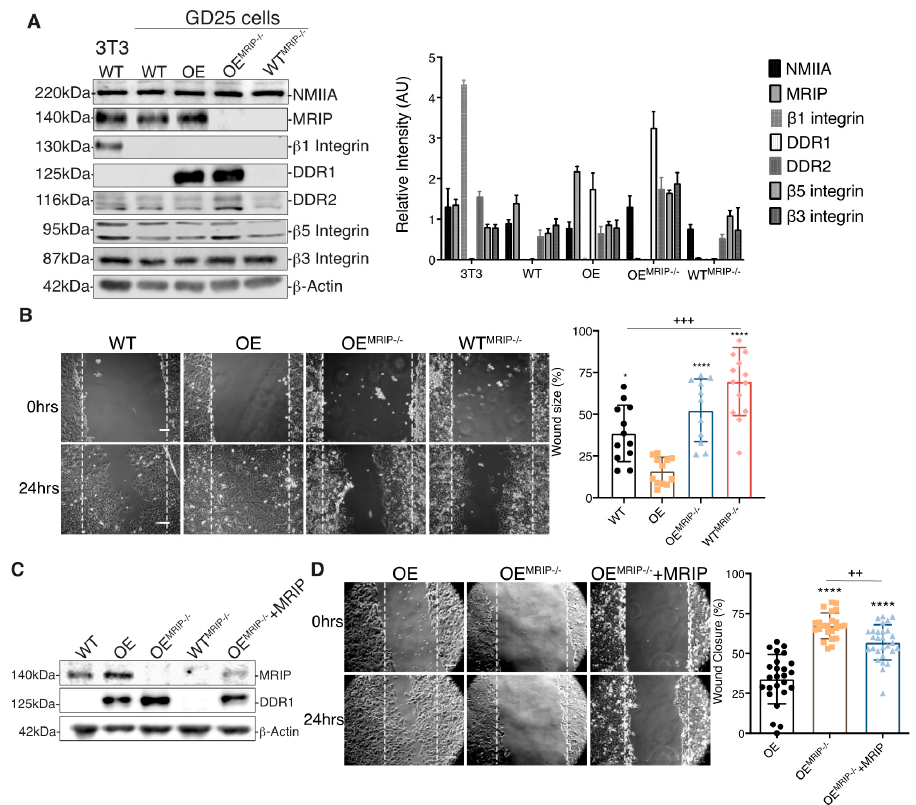
Figure 2. MRIP deletion inhibits cell migration on collagen. ( A ) Immunoblots for evaluation of indicated protein expression levels in whole cell lysates of NIH 3T3 WT, GD25- WT, OE, OE MRIP-/- , and WT MRIP-/- cells. The plot on the right represents the ratio of indicated proteins to β -actin levels for the in vitro cell model. ( B ) Wound-healing assay of confluent monolayers of WT, OE, OE MRIP-/- , and WT MRIP-/- cells cultured on collagen and record at 0, 4, 8, and 24 h post-wounding (B, 0 and 24 h) and quantified in the plot on the right. ( C ) By Western blot we found an approximately 25% restoration of MRIP expression in OE MRIP-/- cells stably transfected with mouse MRIP variant 1 (OE MRIP-/- +MRIP). The indicated cell lysates were also immunoblotted for DDR1 and for β -actin. ( D ) Wound-healing assay of confluent monolayers of OE, OE MRIP-/- , and OE MRIP-/- +MRIP cells cultured on collagen. Wound closure was recorded every hour for 24 h after wounding. Quantification is shown in the plot on the right. Data are reported as mean ± SD, n = 3, * p < 0.05, ++ p < 0.005, +++ p < 0.0005, **** p <0.0001. Scale bar, 10 μ m.